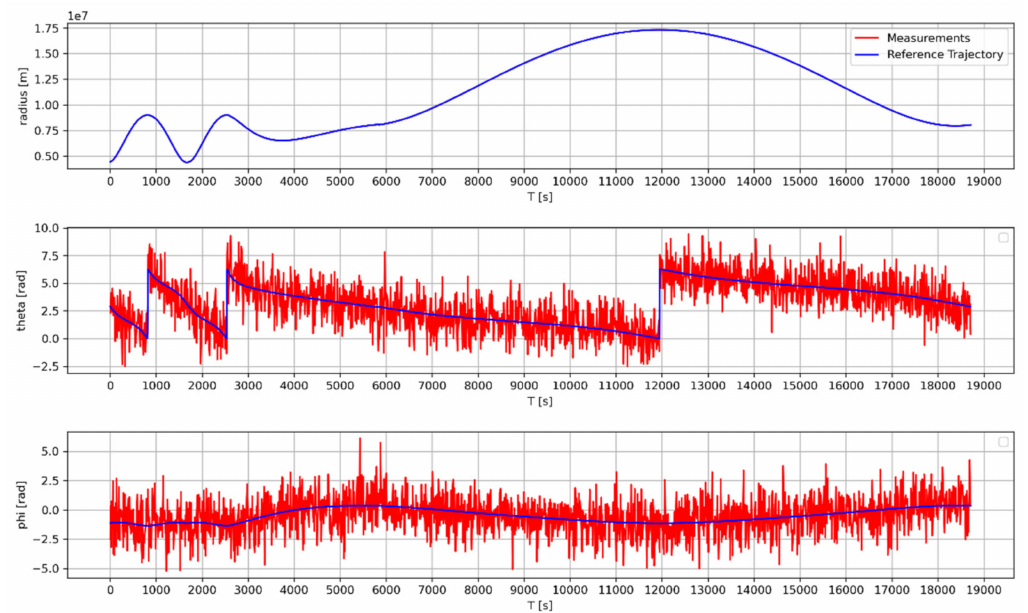
Figure 13. Radar measurements of the orbit